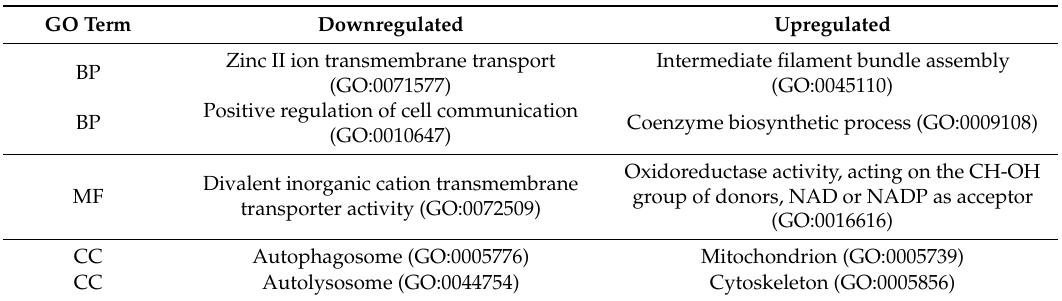
Table 1. Gene ontology (GO) terms enrichment from the bioinformatic analysis of dysregulated proteome in